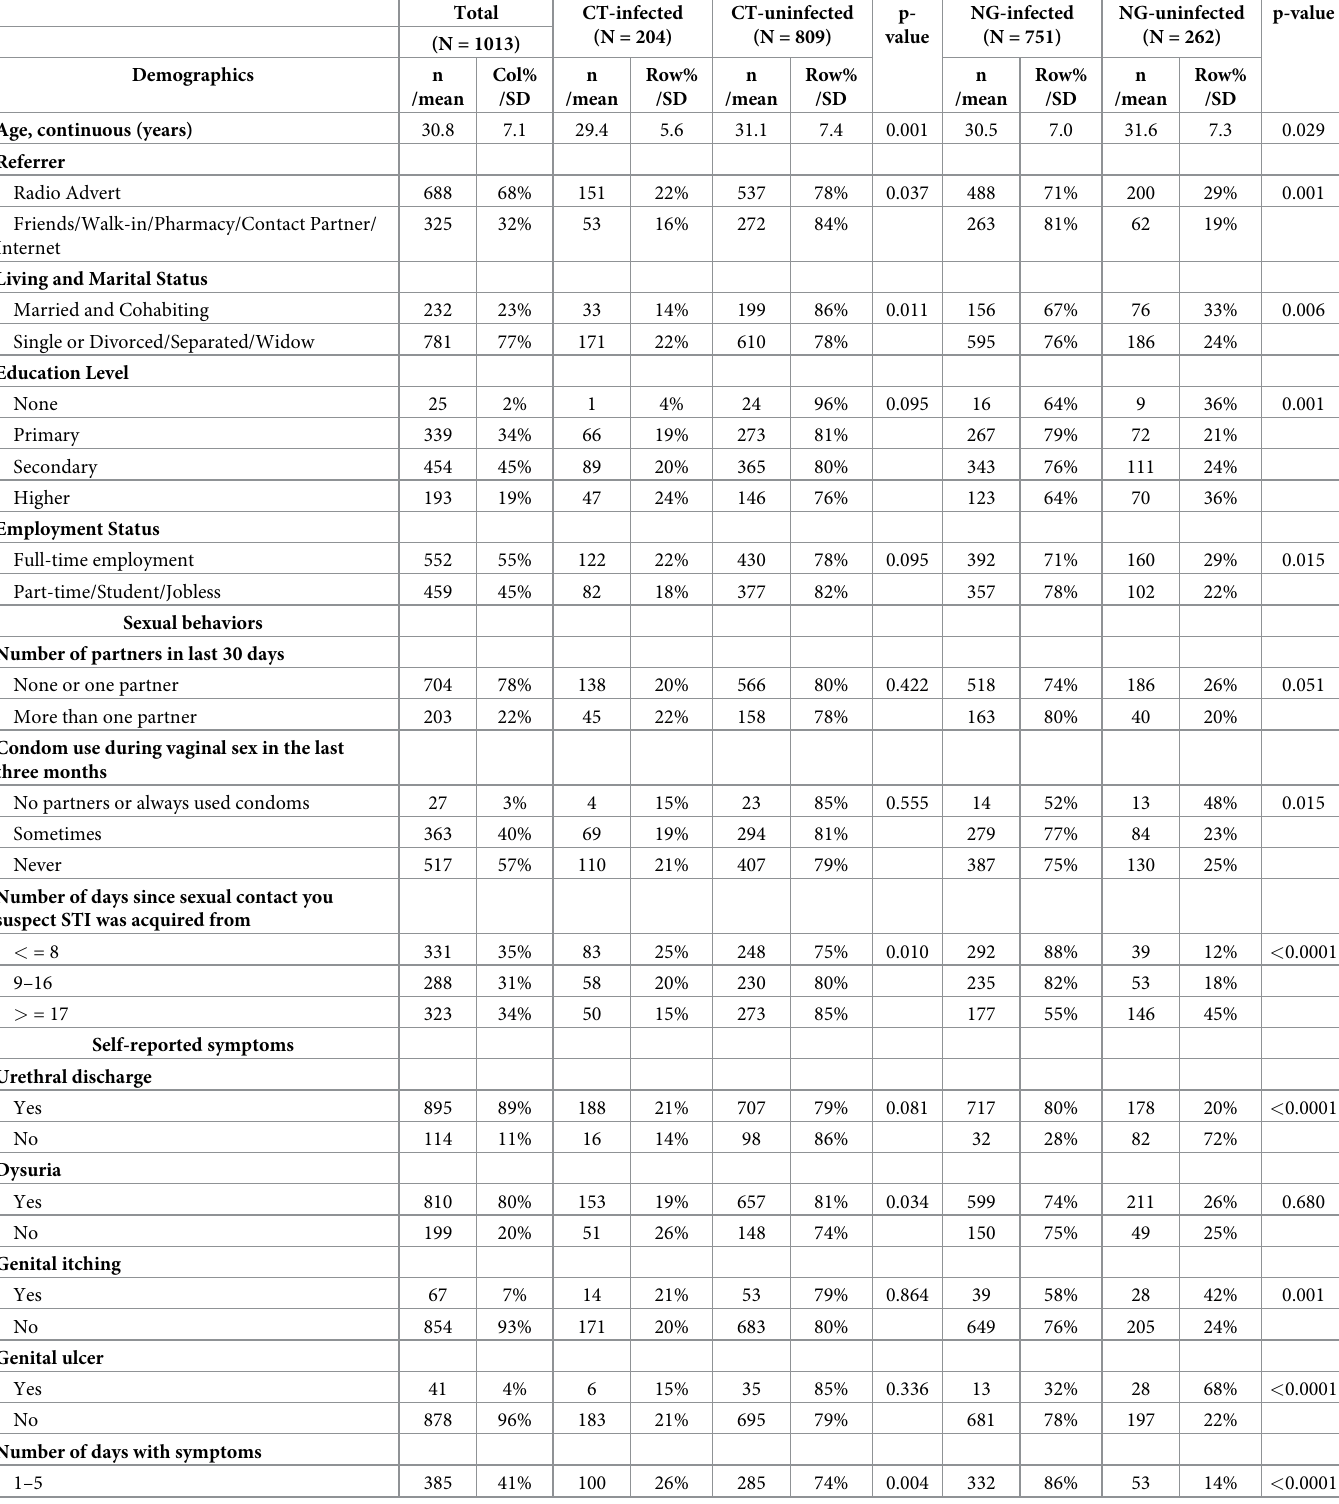
Table 2. Factors associated with CT or NG infection in men in Kigali, Rwanda (N =